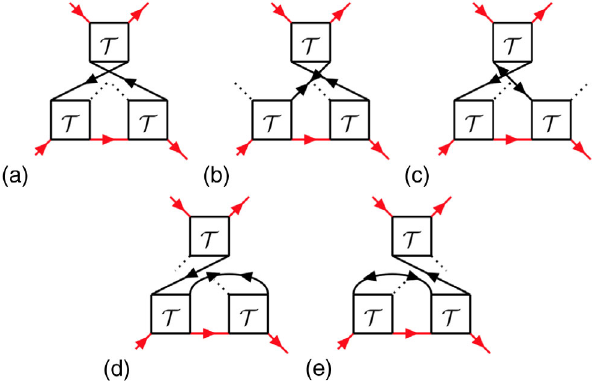
FIG. 11. Diagrams obtained from the dependence of the T matrices in Fig. 6 on the impurity density. We do not show the equivalent diagrams, where two T matrices are on top and one